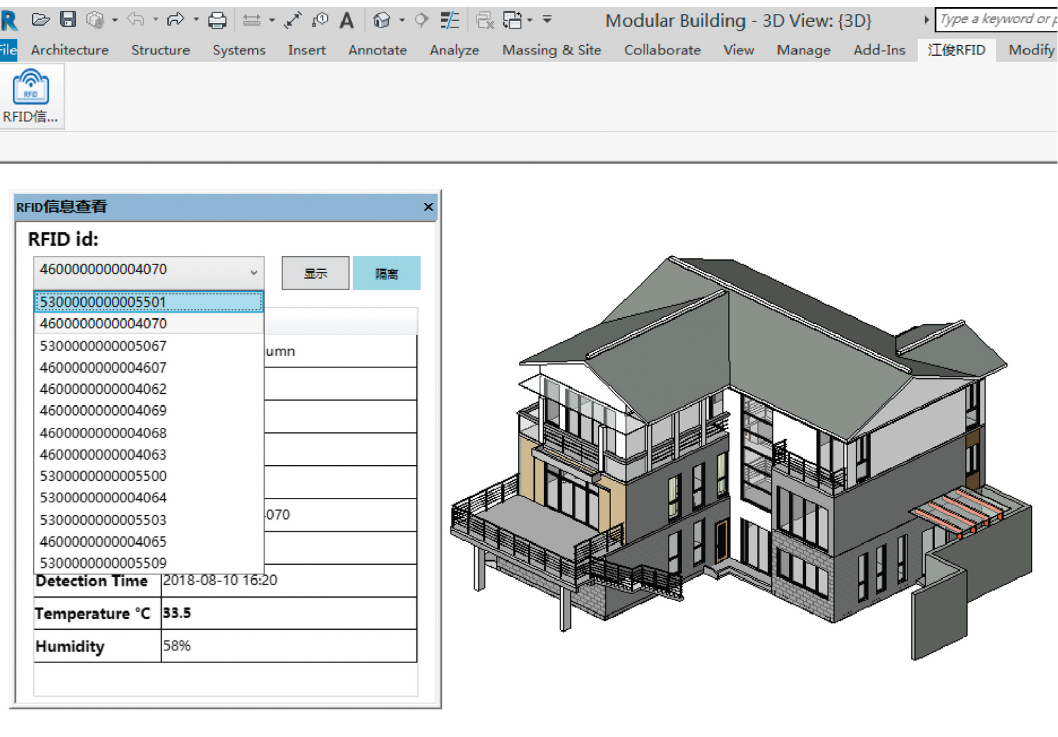
Figure 9: RFID information system.